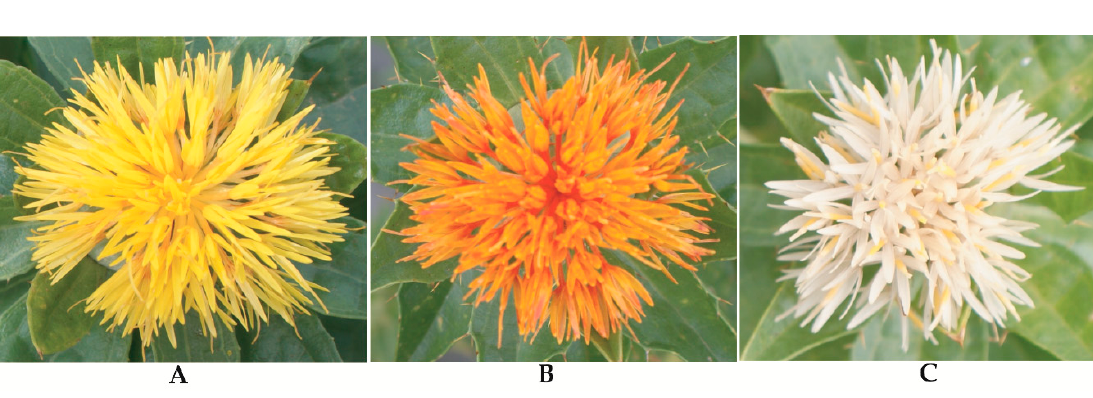
Figure 1. Differential flowering phenotypes of Carthamus tinctorius L.: ( A ) Yellow (The Germplasm Resources Information Network database, PI251398), ( B ) red (PI253529), and ( C ) white (PI209297).